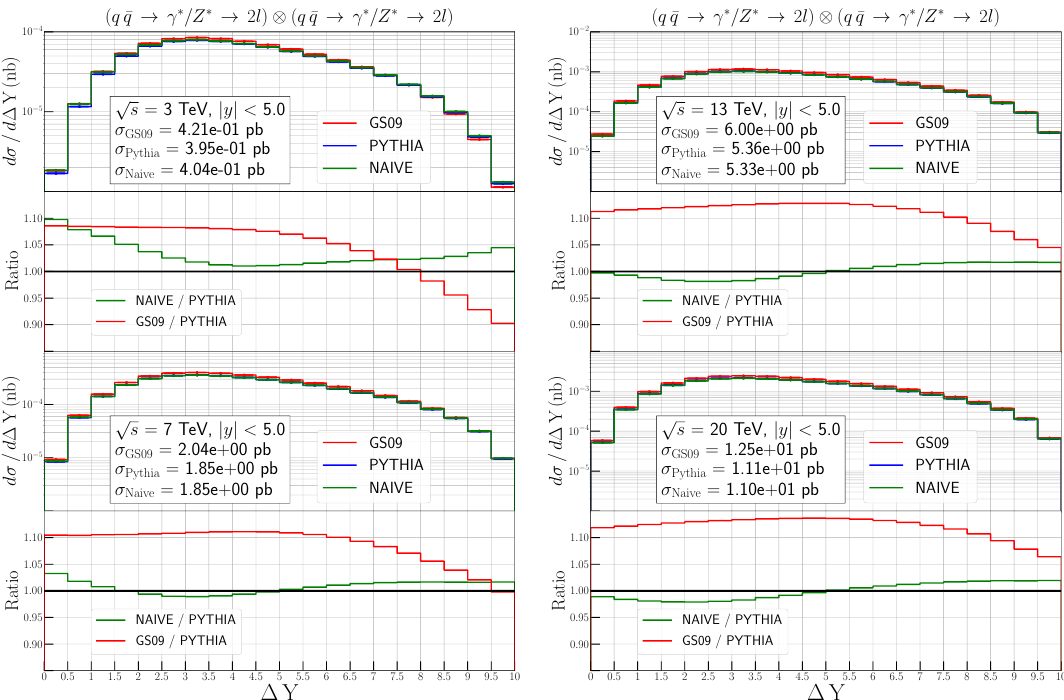
Figure 8 . Comparison between ∆Y = max | y i − y j | DPS distributions generated with the GS09, P YTHIA and naive dPDFs. The collision energy